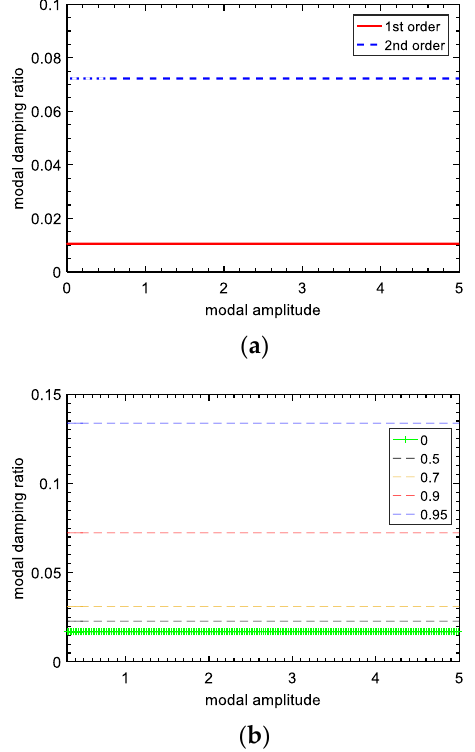
Figure 8. Modal damping ratio vs. modal amplitude: ( a ) modal damping ratios of the lumped model; ( b ) modal damping ratio changing curves in different γ net